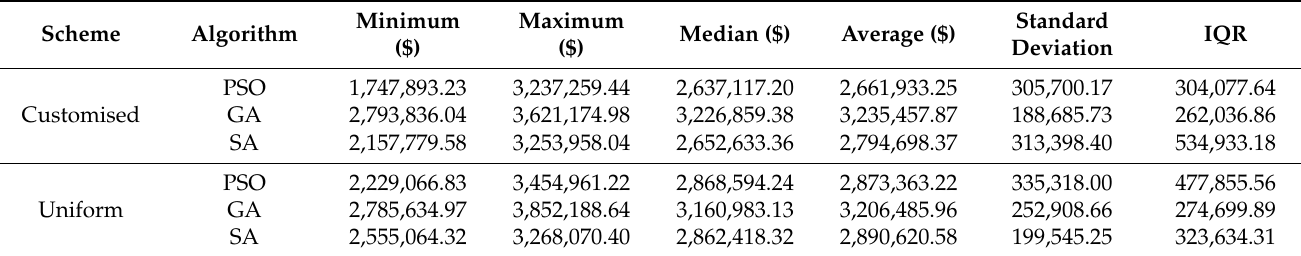
Table 4. Statistical results of three hybrid solution